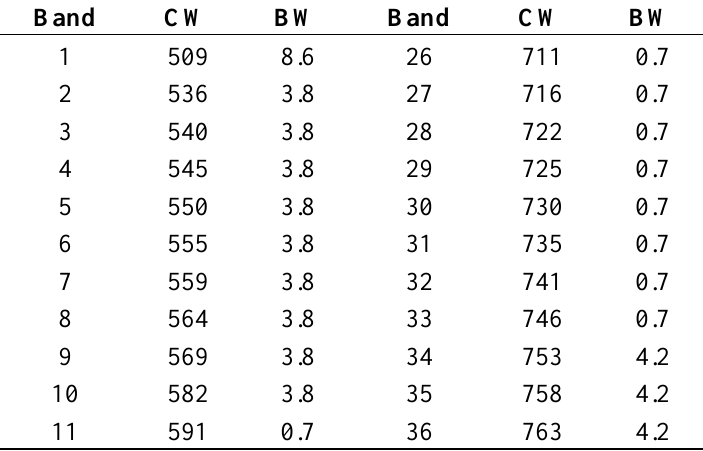
Table 1. Waveband characteristics of Airborne Imaging Spectrometer for Applications (AISA) used to acquire hyperspectral imagery of a musk thistle infestation in grassland near the city of Friona, TX, USA in